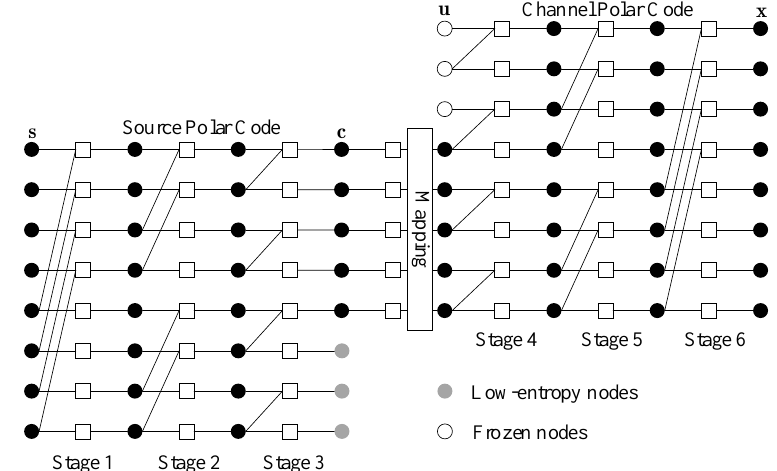
Figure 2. The joint factor graph of the D-PC scheme.